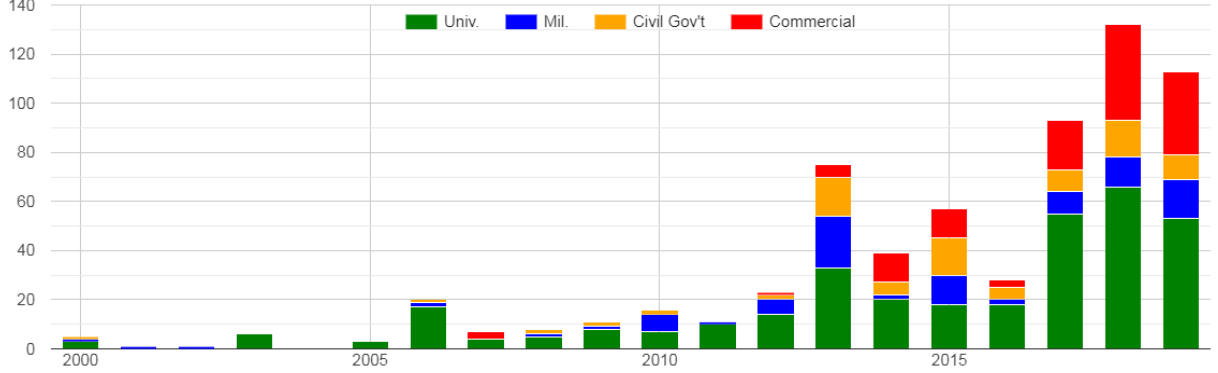
Figure 2. CubeSat mission types from 2000 until present, according to [2].